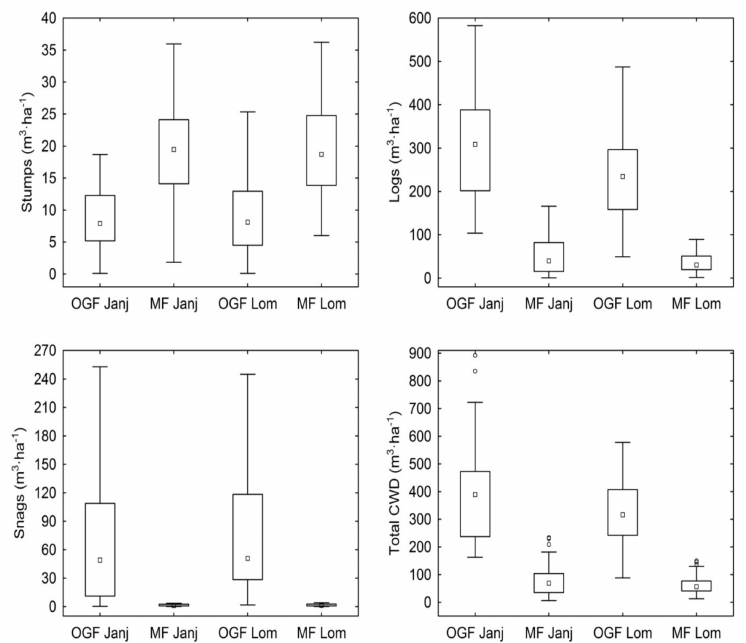
Figure 2. Box-plots for the volume of stumps, logs, and snags and total CWD in old-growth forests (OGFs) and managed forests (MFs) in Janj and Lom. The box represents the interquartile range, and the small square inside the box shows the median. The whiskers extend to the lowest and highest values below and above the first and third quartile, respectively, excluding outliers. Circles represent outliers that are more than 1.5 times the interquartile